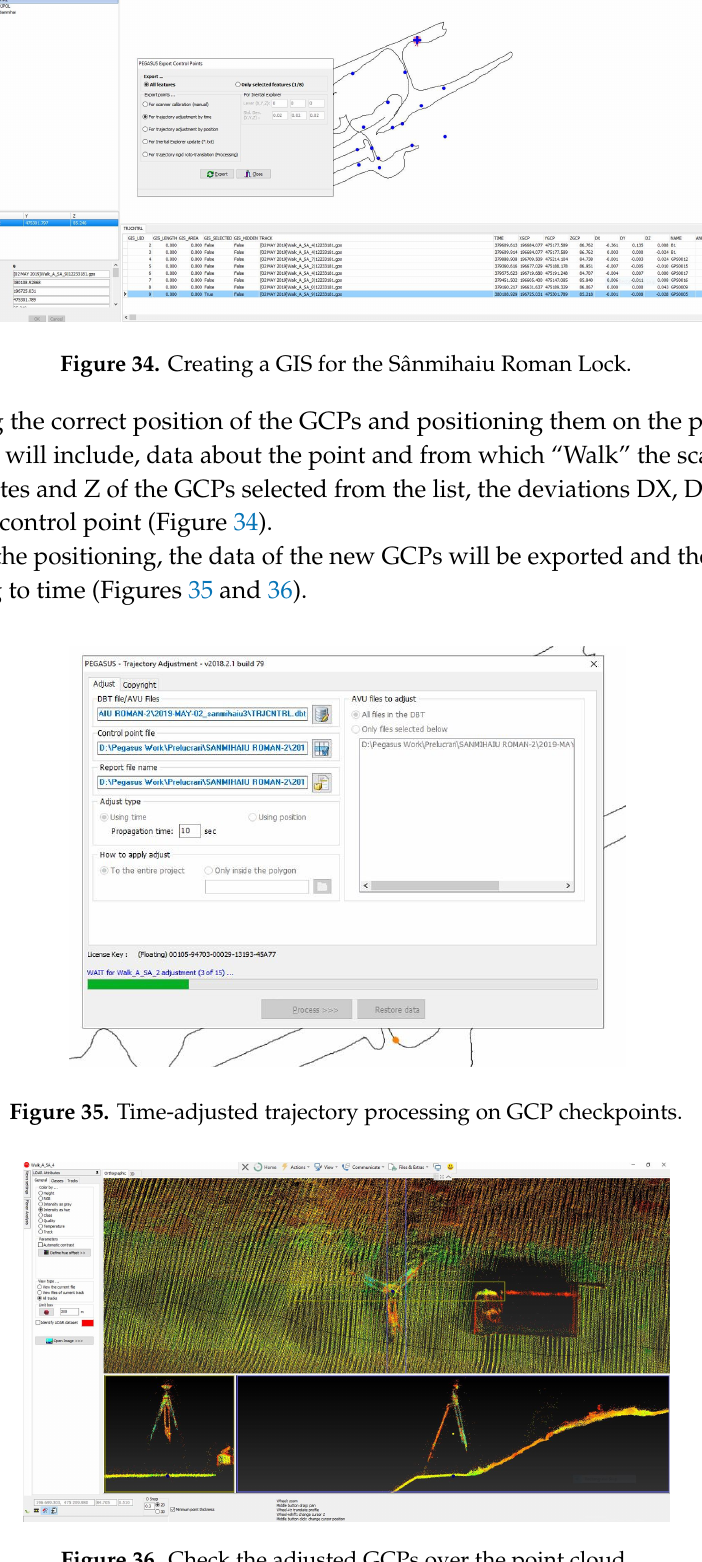
Figure 37. View time-adjusted point clouds on GCP.